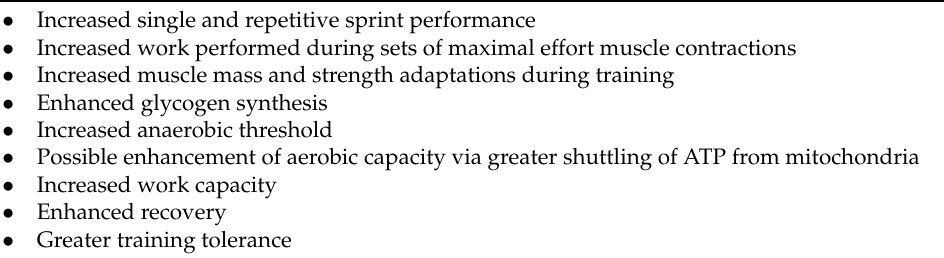
Table 1. Potential ergogenic benefits of creatine supplementation.